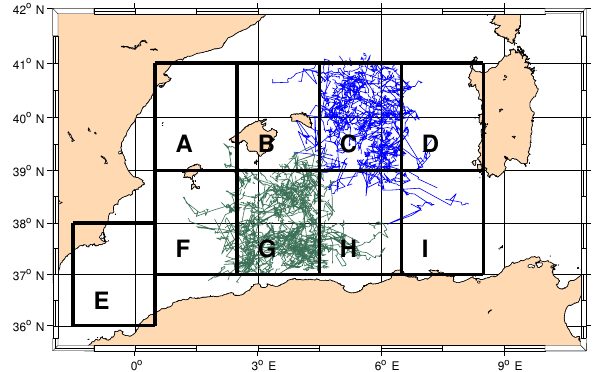
Figure 13. Tracks of the short-life eddies formed in sectors C (blue), F (lilac) and I